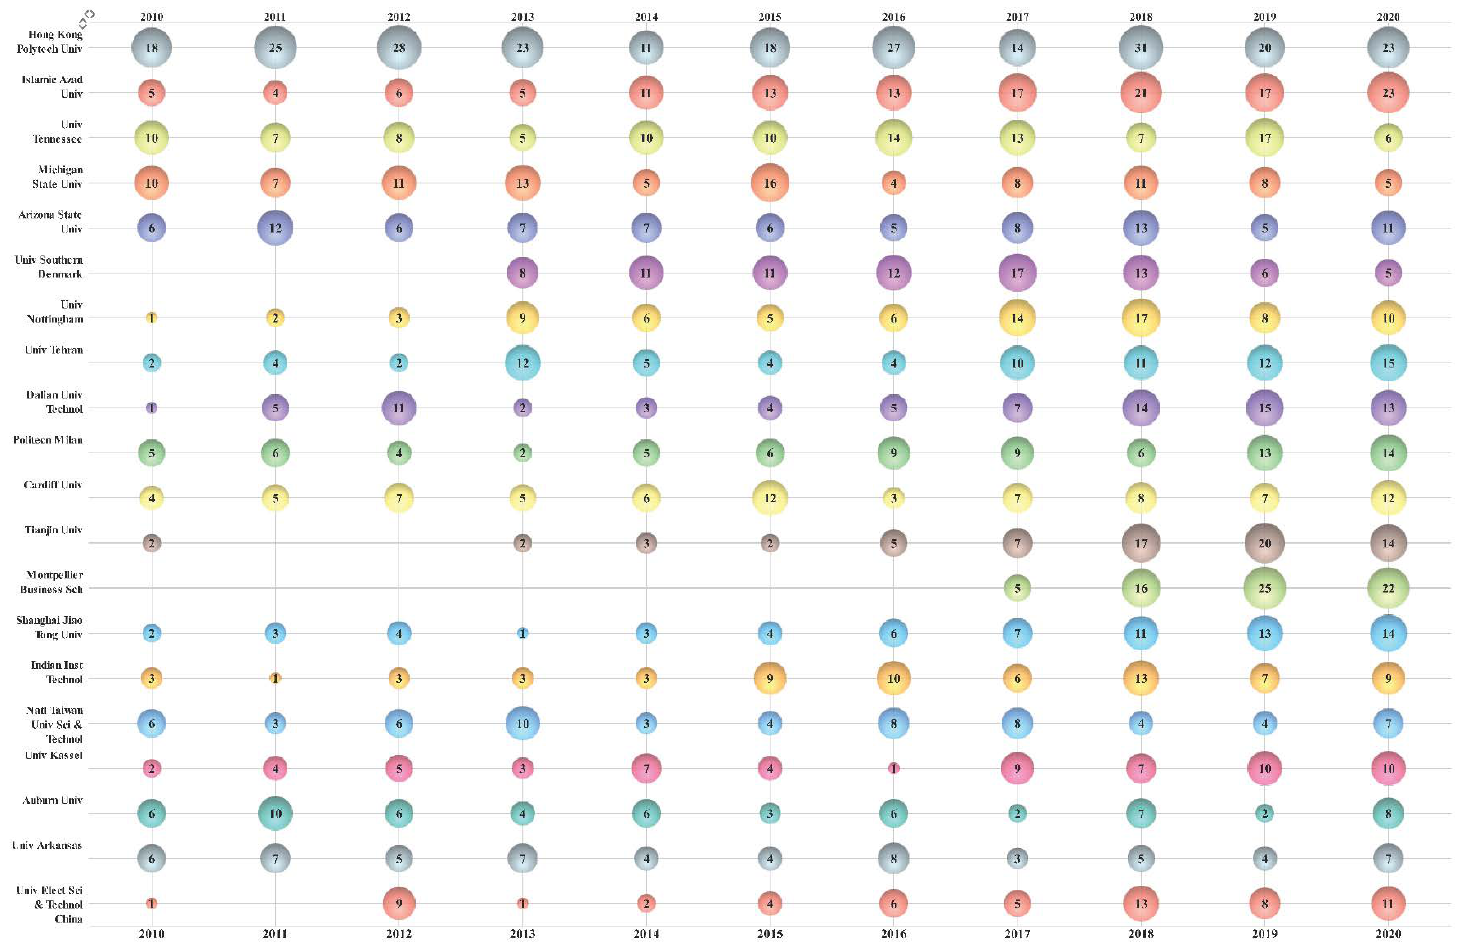
Figure 6. Bubble chart of top 20 productive journals institutions.